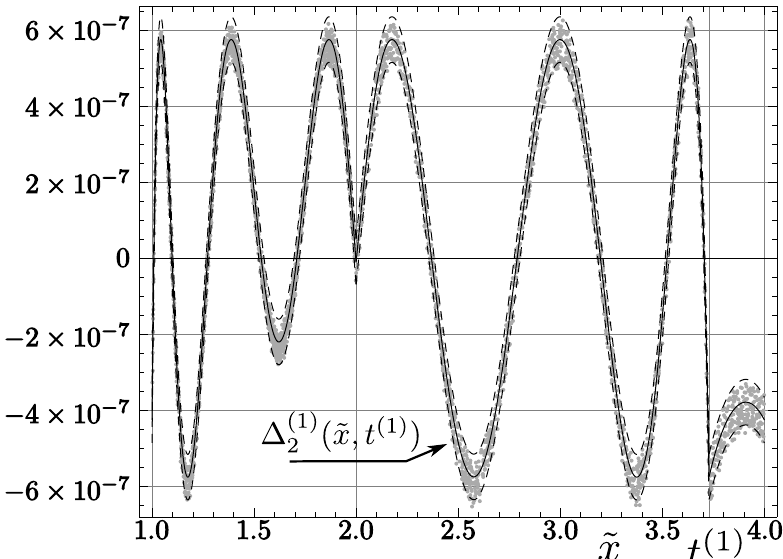
Figure 2. Solid lines represent function ∆ dashed lines. Finally, dots represent relative errors for 4000 random values x ∈ ( 2 − 126 ,2 128 ) produced by algorithm InvSqrt 1.